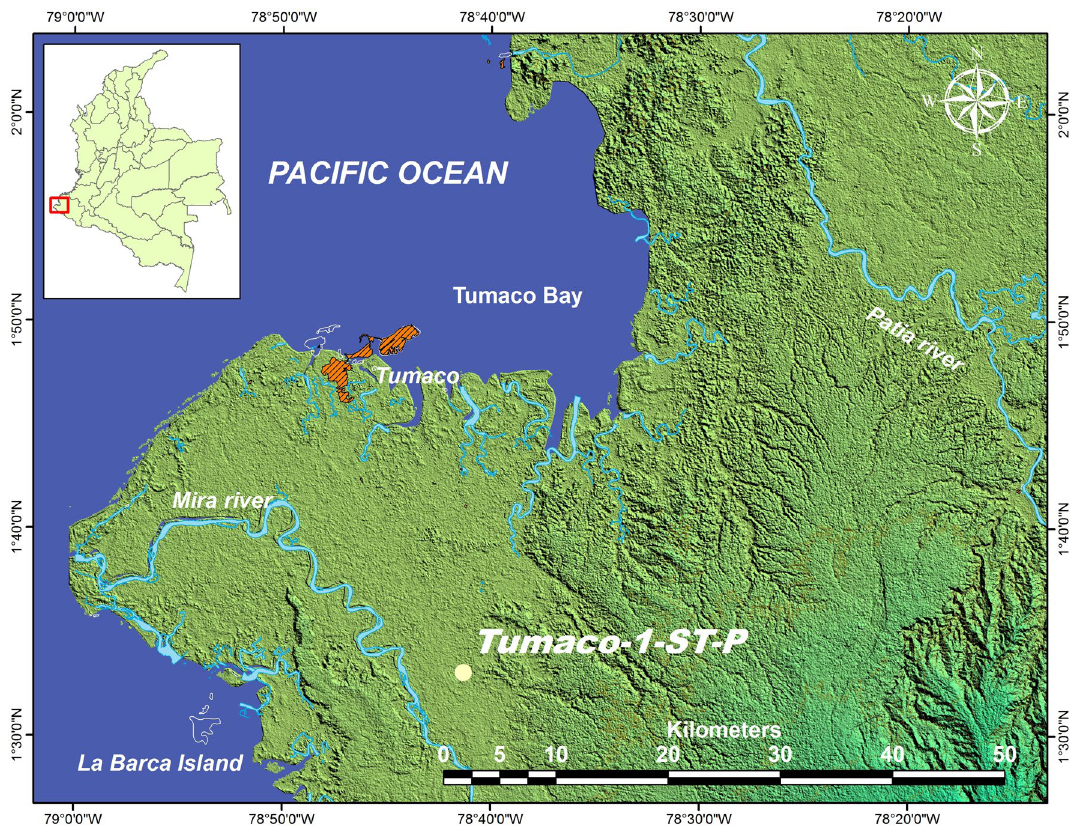
Fig. 1 Map showing the study area and location of the Tumaco-1-ST-P stratigraphic well (ANH-Antek S.A.